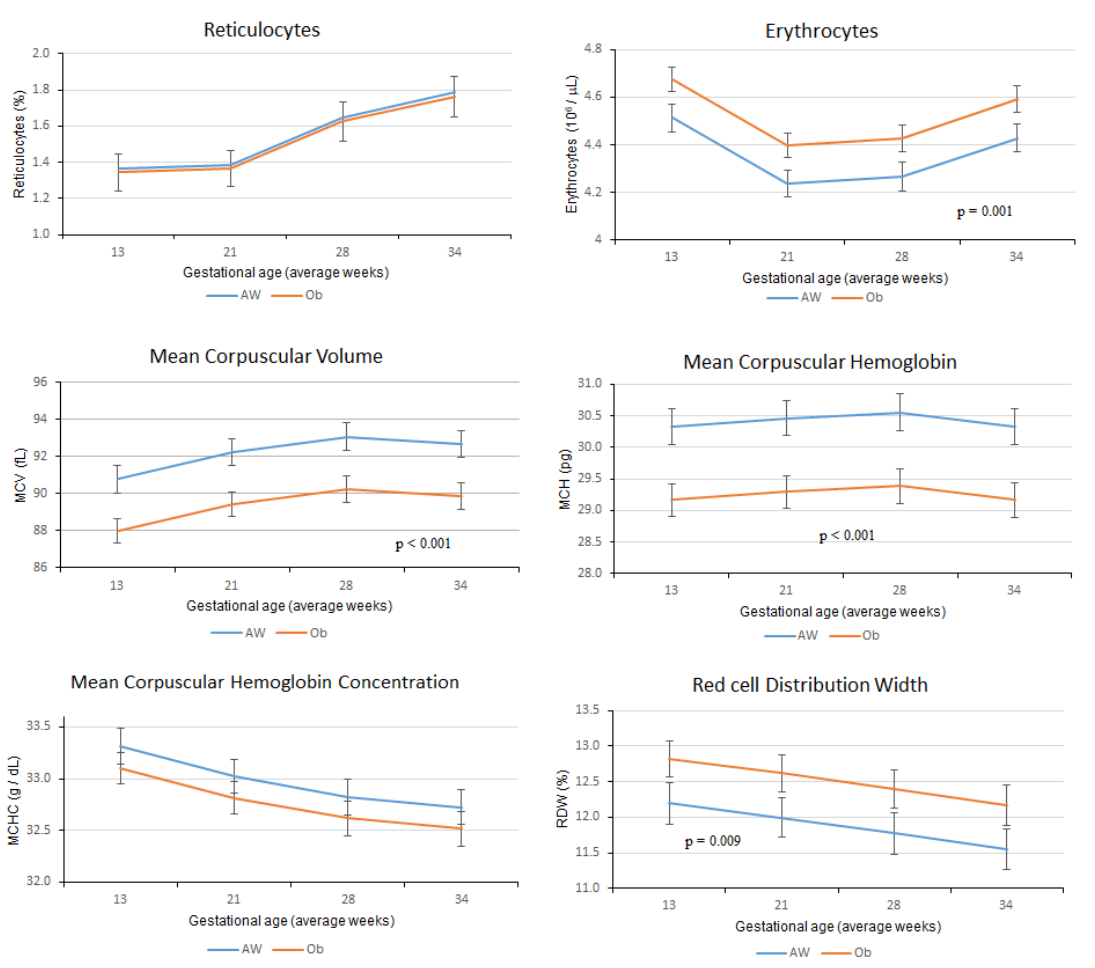
Figure 3. Di ff erences in red cell indices between adequate weight (AW) and obesity (Ob) study groups. Adjusting models for inflammation by adding IL – 6 did not alter the observed differences.